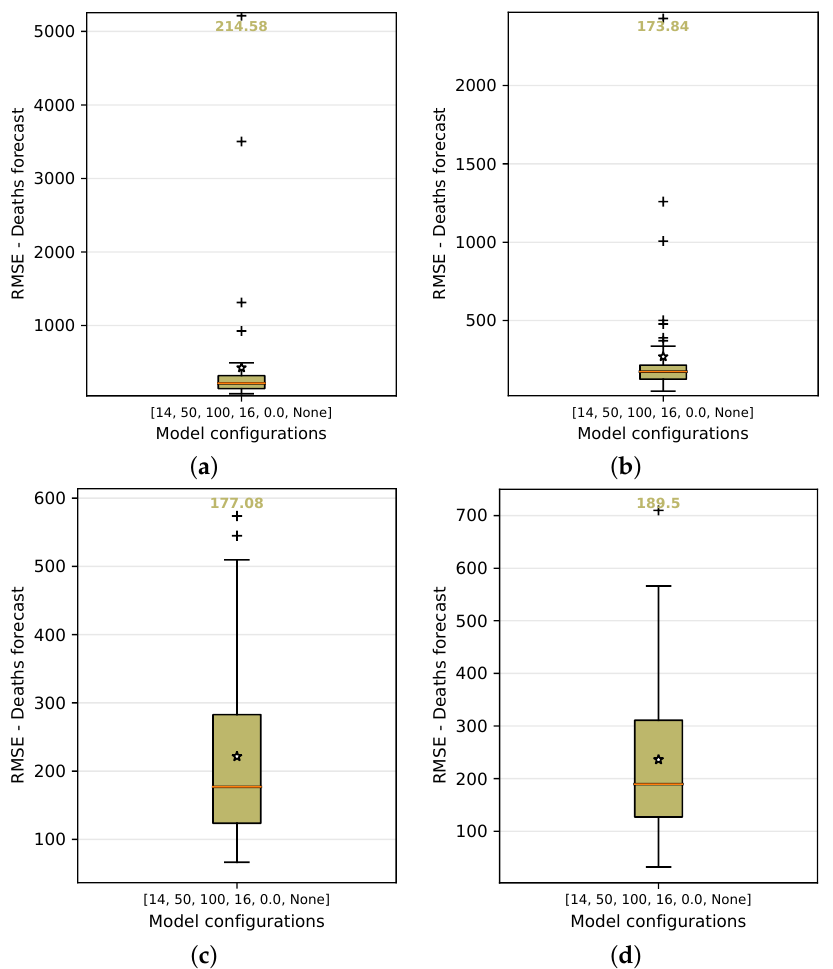
Figure 16. RMSE median and average error in the boxplot on grid search using the following as input data: Cases, Cases + R 0 , R 0 + R e + Holiday flag, and PC 1 + PC 2 . For each configuration, the graphs show the median and average of the accumulated error in predicting deaths over 50 repeated experiments. ( a ) Cases. ( b ) Cases + R 0 . ( c ) R 0 + R e + Holiday flag. ( d ) PC 1 + PC 2